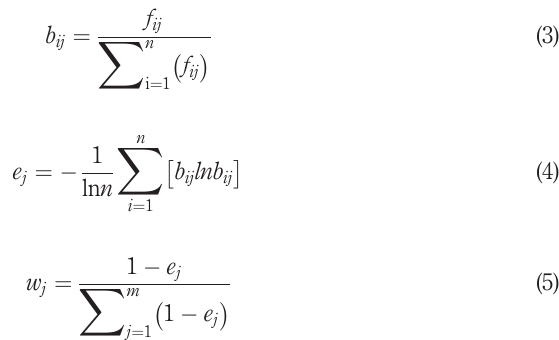
where b is the proportion of the standardized value for the j -th indicator in the i -th year in ij the entire evaluation year series, e weight for the j -th indicator, with the constraint being 0 # w